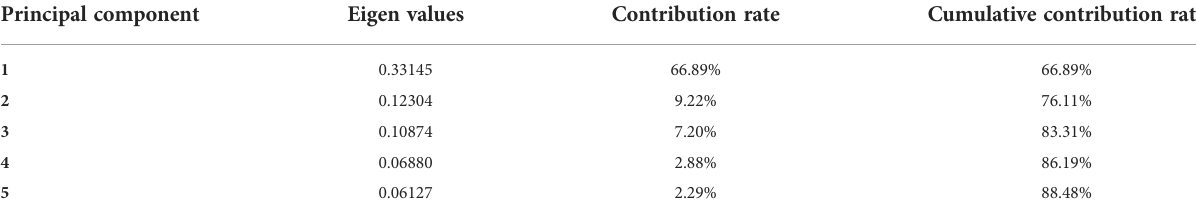
TABLE 4 Eigenvalues and contribution rates of the fi rst 5 principal components of relative warps scores of different morphological features of the test Siberian sturgeon. Principal component Eigen values Contribution